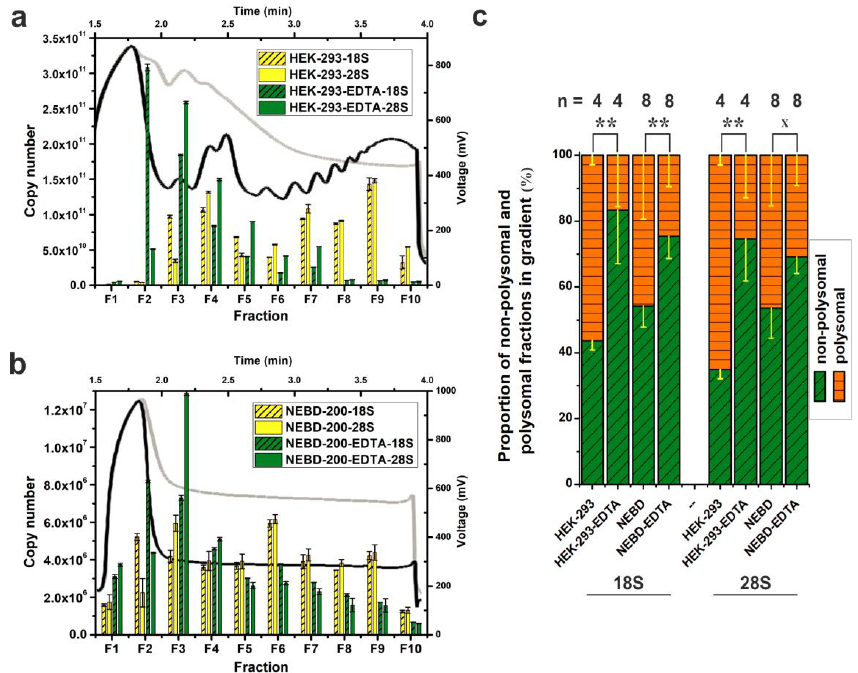
Figure 2. qRT-PCR-based visualization of polysome profiles from scarce samples using SW55Ti tubes. Comparison of polysome profiles of HEK-293 cells ( a ) and 200 NEBD-stage oocytes ( b ). Black curves and yellow columns in each chart indicate untreated lysates; EDTA-treated polysome profiles are traced in light grey and green columns. Absolute copy number of 18S and 28S rRNA was determined in fractions F1–F10 and error bars display ±SD of qPCR technical triplicates. ( c ) Proportion of the non-polysomal (NP, fractions F2–F5, in green) and polysomal (P, fractions F6–F10, in orange) parts of profiles from untreated and EDTA-treated HEK-293 cells and NEBD-stage oocytes; error bars, ±SD; n , number of independent biological replicates; ** p < 0.001; x signifies a lack of significance; only non-treated and EDTA-treated pairs from Dunn’s multiple comparison are displayed.